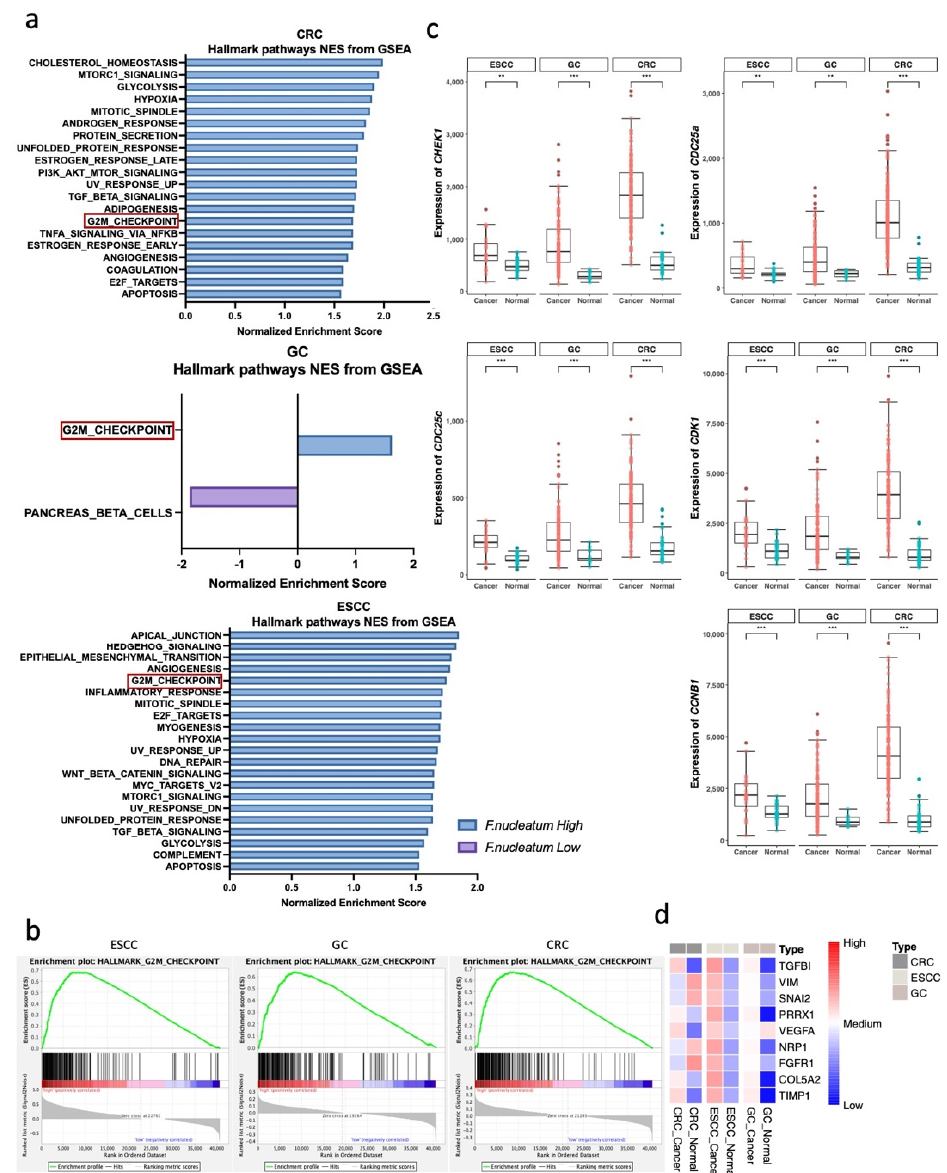
Figure 3. DEGs and GSEA analysis of GI tract cancer WTS data. ( a ) Barplot indicating normalized enrichment score (NES) in F. nucleatum − high vs. F. nucleatum − low groups for every cancer type. ( b )